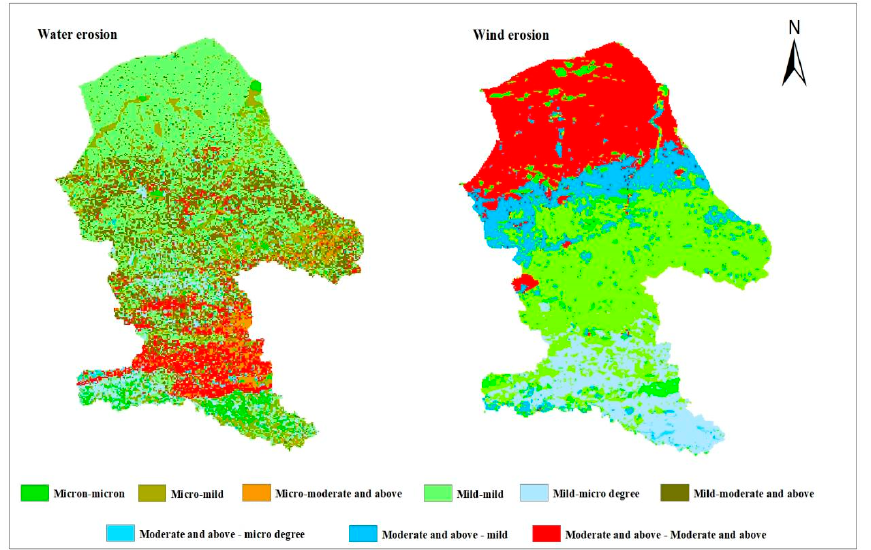
Figure 4. Soil water erosion and soil wind erosion intensity transfer matrices in Baotou City. According to the above analysis, the series of recent governing projects in the Yellow River Basin, such as small basin management, soil and water conservation and other re ‐ gional mountain closure and forest cultivation, farmland return to forest, and strength ‐ ened river bank protection and slope protection, can inhibit soil water erosion to some extent. However, serious soil–water loss remains. Soil wind erosion was mitigated, to some extent, because of the Beijing–Tianjin sandstorm source control. The regional wind ‐ proofing and sand ‐ fixing abilities were strengthened, which decreased sandstorm dam ‐ age to a large extent. 3.2. Spatial Evolutionary Laws of Soil Erosion across 30 Years Since the 1990s, the spatial distribution features of water and wind erosion moduli in Baotou City have generally been kept constant. Specifically, the water erosion modulus presents a rising trend, whereas the wind erosion modulus presents a decreasing trend (Figures 5 and 6).